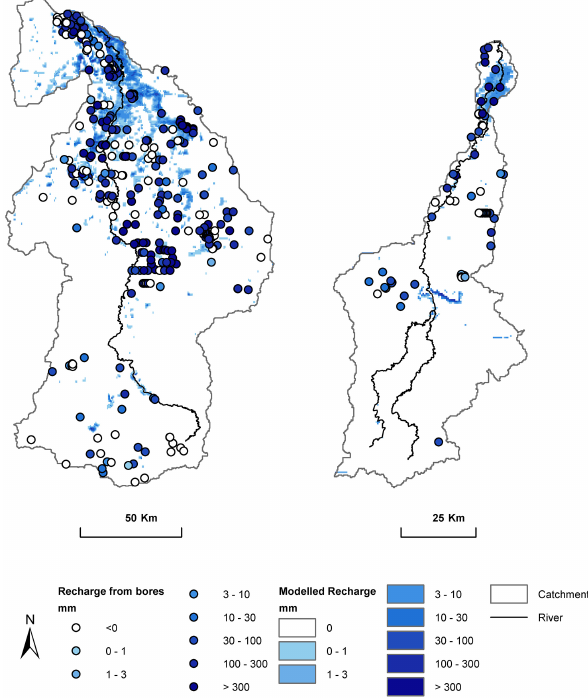
Fig. 5. Modelled OFR and recharge calculated from bore responses for the Loddon and Campaspe